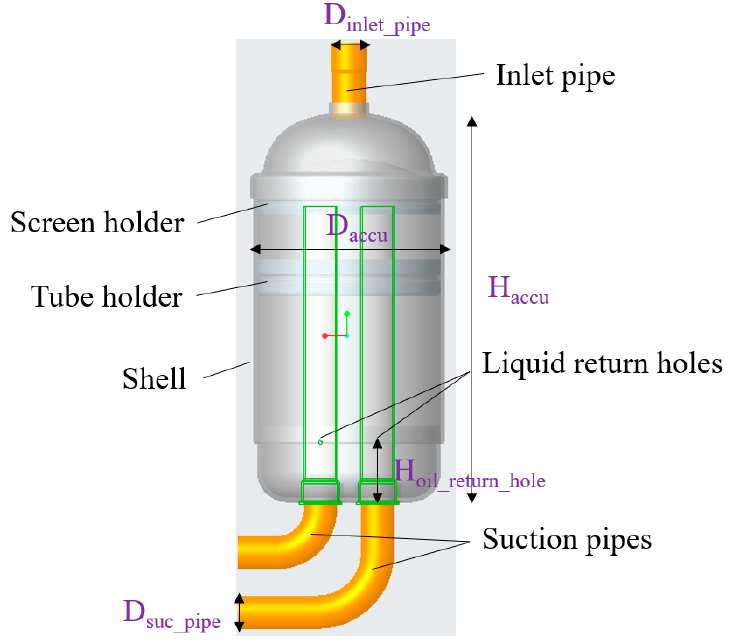
Figure 2. Geometry model of the accumulator.